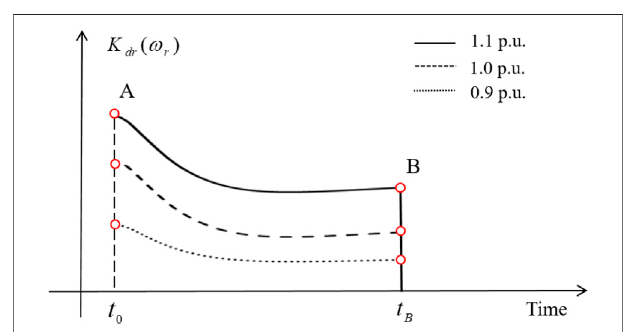
FIGURE 4 | Diagram of the conventional droop control gain in the time domain.